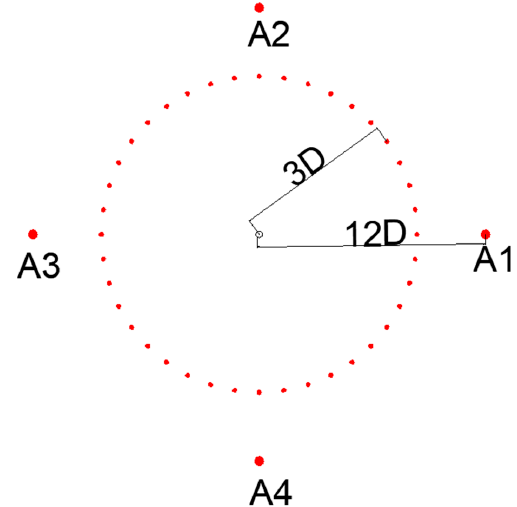
Figure 12. Acoustic monitoring points setting.